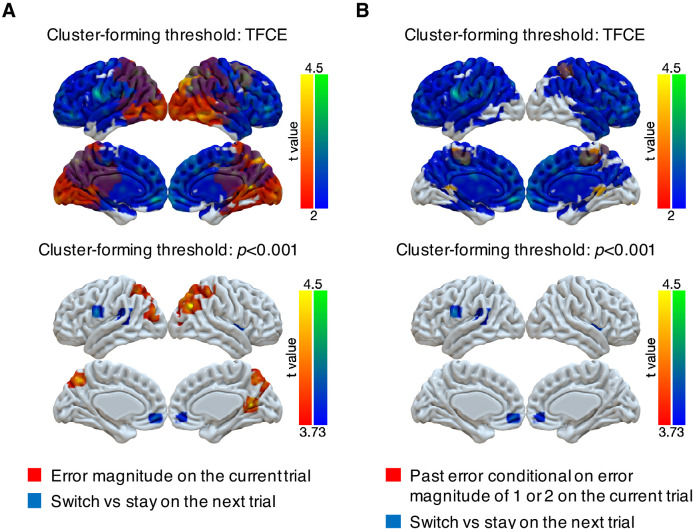
Representations of subsequent behavioral choices (switch versus stay) thresholded via threshold-free cluster enhancement (TFCE) or with a cluster-forming threshold of p<0.001.(A) Overlap of results for switch versus stay on the next trial and error magnitude on the current trial. We implemented two types of cluster-forming approaches: TFCE and uncorrected voxel p<0.001. First, significance testing was implemented through permutation tests with threshold-free cluster enhancement (FSL’s randomize), which does not require a pre-defined cluster-forming threshold. The result of switch versus stay showed little spatial specificity. For the purpose of display, the results were thresholded based on uncorrected voxel p<0.03 (t = 2). Second, we used a cluster-forming threshold of uncorrected voxel p<0.001 (t = 3.73) and tested the significance of the formed cluster via one-sample cluster-mass permutation tests with 5000 iterations. The results showed high spatial specificity and several previously identified regions were still significant: middle cingulate cortex [14, -8, 30], right insula [38, 4, 2], medial OFC [−4, 50,–10], left premotor cortex [−62, 2, 24] and left superior temporal gyrus [−50,–32, 12]. (B) Overlap of results for switch versus stay on the next trial and past error conditional on error magnitude of 1 or 2 on the current trial. The two types of cluster-forming approaches are shown.